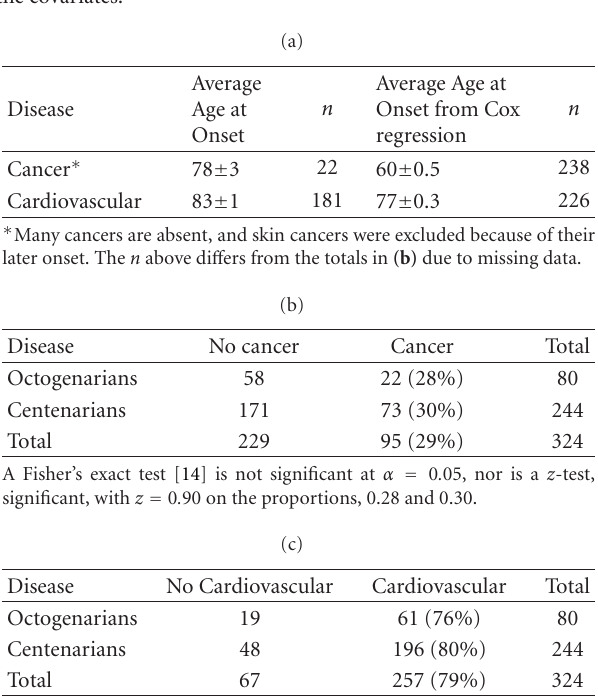
Table 4: Age at onset of chronic disease and lifetime prevalence in control group of 80 octogenarians versus 244